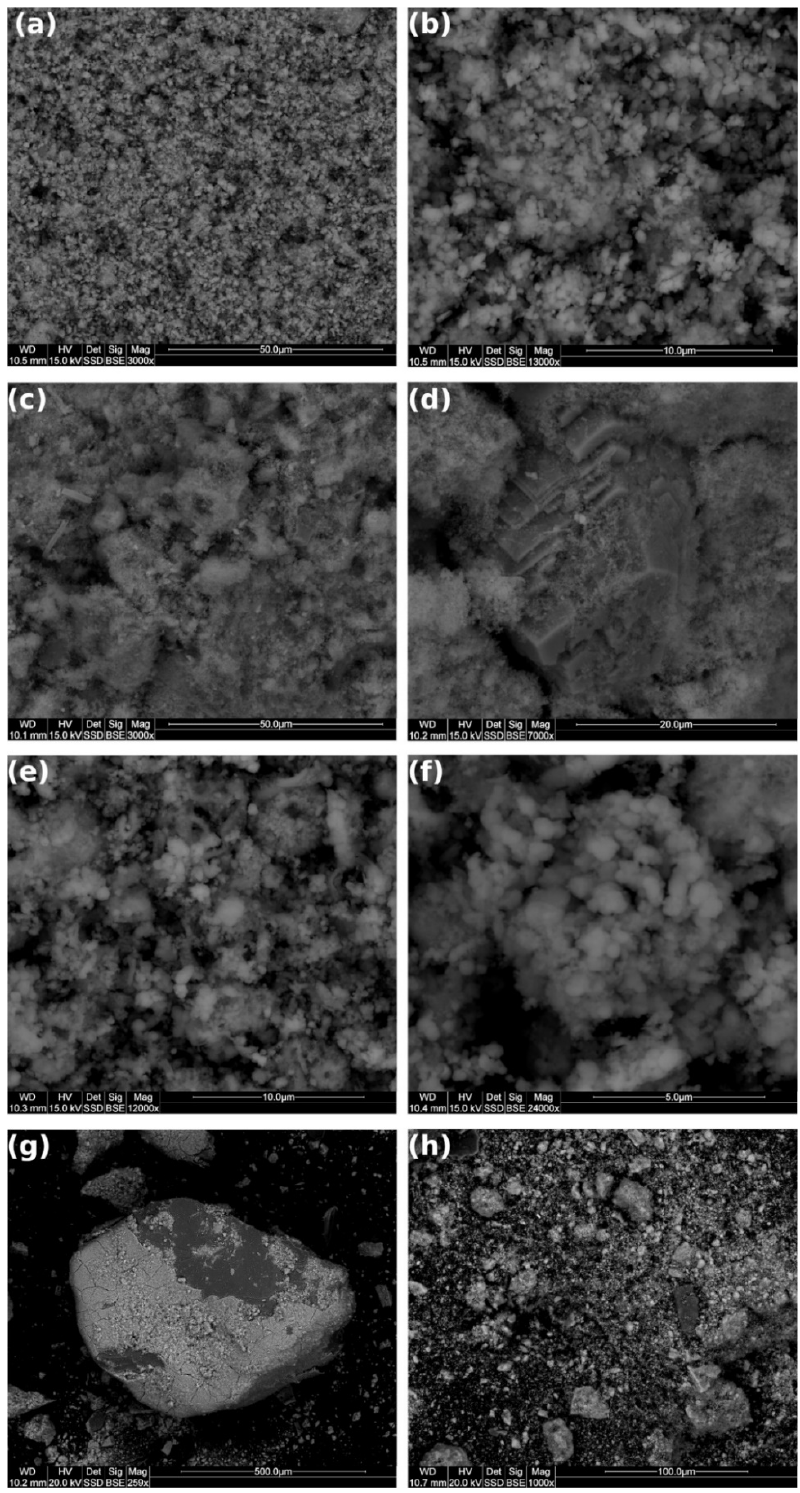
Figure 5. SEM images of samples: ( a , b ) GWTR-1; ( c , d ) GWTR-2; ( e , f ) GWTR-3; ( g , h ) GWTR-4 (WD—working distance, HV—high voltage, Det—detector, Sig—signal, Mag—magnification, SSD—Single Shot Detector, BSE—Backscattered Electrons.